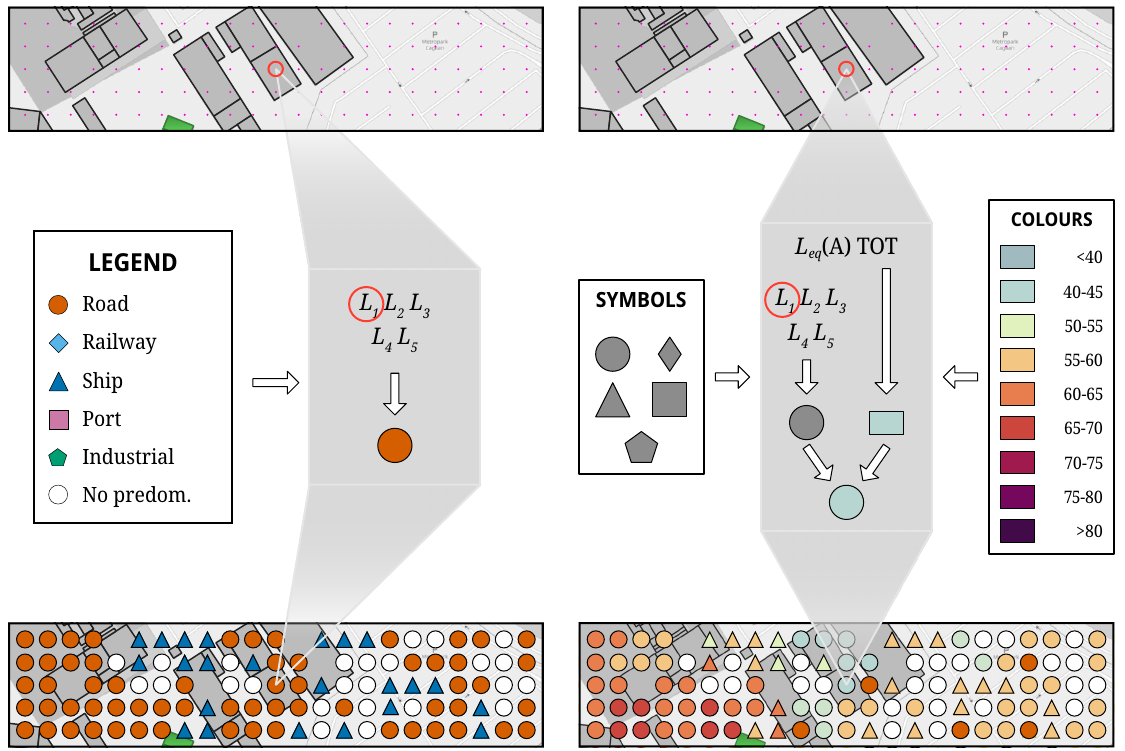
Figure 1: Sketches of the two